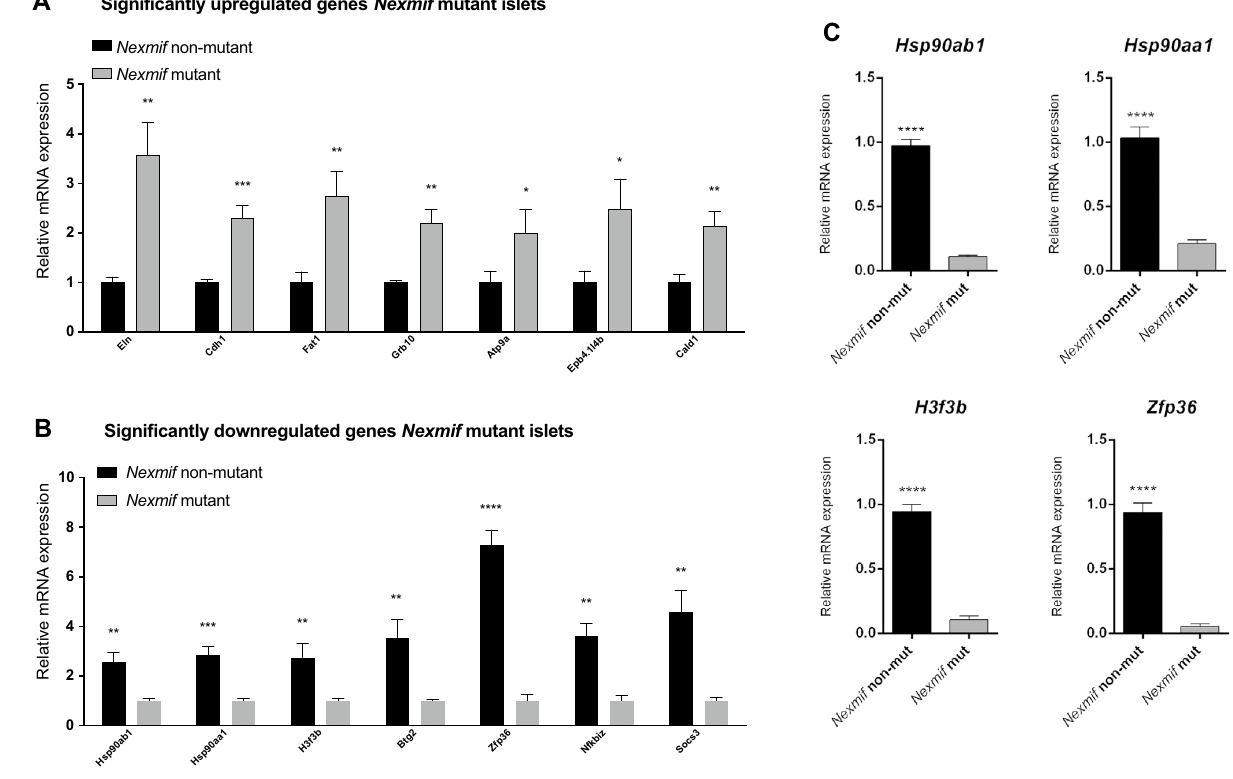
Figure 4. RNAseq in pancreatic islets of Nexmif mutant mice. ( A ) Gene expression profile of differentially expressed genes in pancreatic islets of male Nexmif mutant and Nexmif non-mutant mice. Kendall’s Tau was used for clustering possibly co-expressed pathway genes (n = 3). RNAseq mRNA expression data from pancreatic islets. The most highly expressed genes that were upregulated at least twofold in Nexmif mutant islets compared with Nexmif non-mutant islets (n = 3) are shown. ( B ) RNAseq mRNA expression data from pancreatic islets. The most highly expressed genes that were downregulated at least twofold in Nexmif mutant islets compared with Nexmif non-mutant islets (n = 3) are shown. ( C ) Confirmation of downregulated genes by qPCR: Hsp90ab1, Hsp90aa1, H3f3b, Zfp36 (n = 3). Error bars indicate the standard deviation. Two-tailed unpaired Student’s t-test: * P ≤ 0.05, ** P ≤ 0.01. *** P ≤ 0.001, **** P ≤